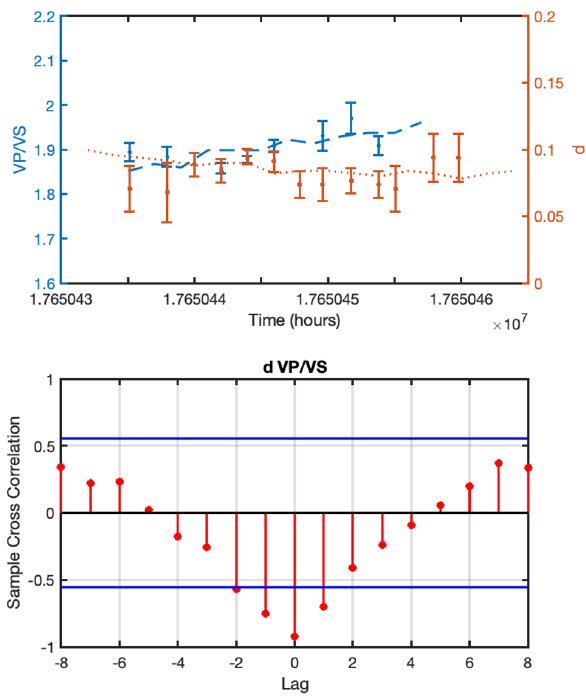
Figure 10. Same as Fig. 6 but for St. Gallen geothermal field and relative to the time period 2013/07/19 12:00:00 up to 2013/07/20 23:00:00 (time-lag = 2 h).